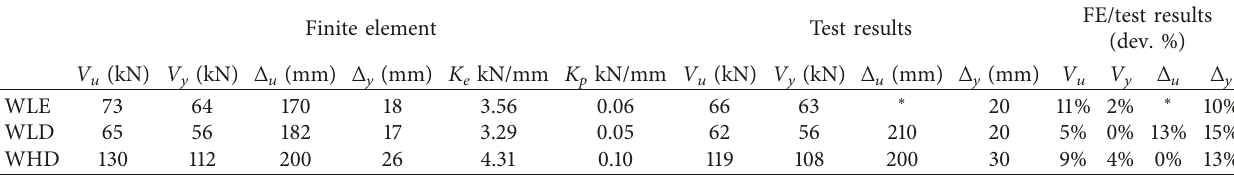
Table 5: Results summary.